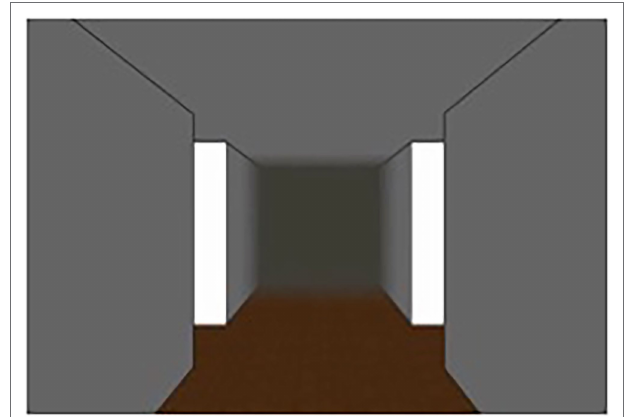
FIGURE 1 | Screenshot of an (empty) intersection taken from Hamburger and Röser (2011,